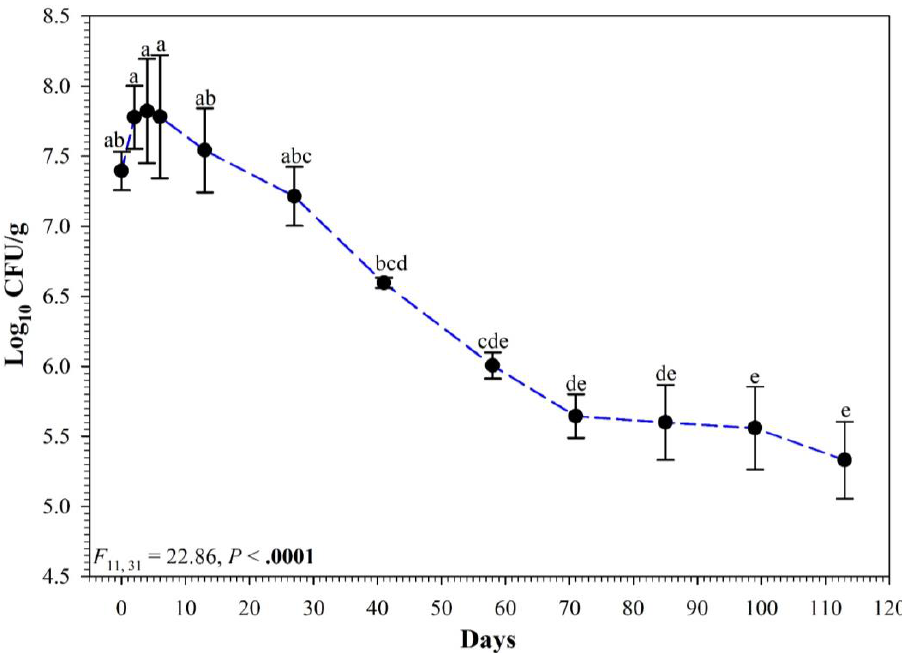
Figure 1. Persistence of virulent Aeromonas hydrophilia population (log 10 CFU g −1 ) over a period of 113 days in soil samples collected from two farms for the pilot trial. Each symbol indicates the mean of four soil samples (two ponds per farm), and error bars around the symbol represent the standard error of the mean. Symbols with different lowercase letters are significantly different at p < 0.05.